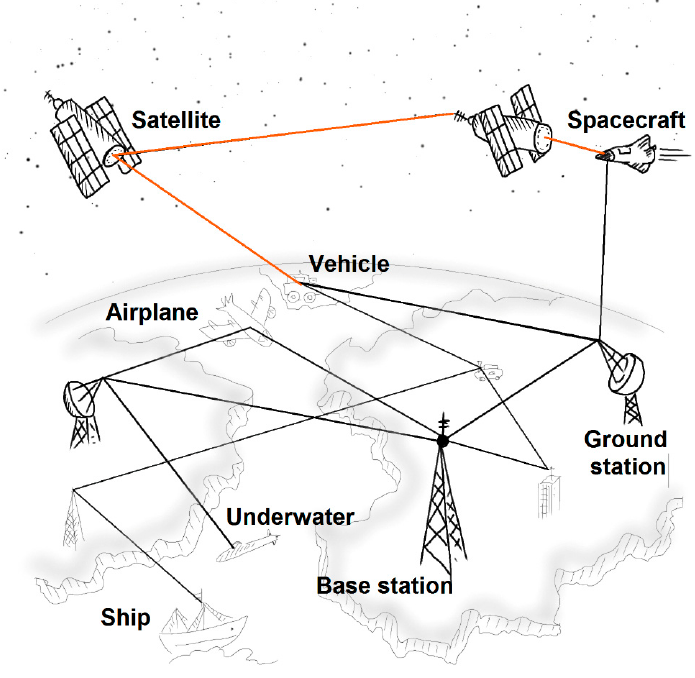
Figure 2. Schematic image of Optical Communication links between different objects. Data transmitted on a narrow beam of laser light is marked in red.